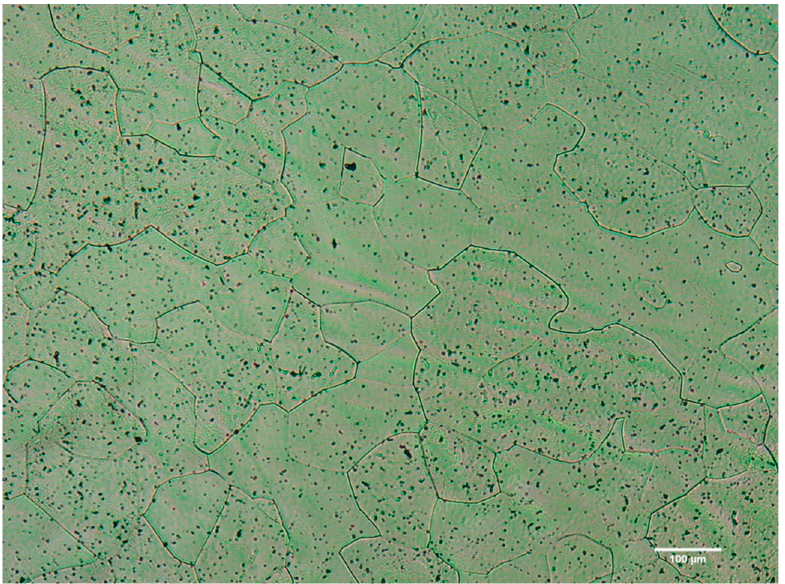
Figure 2. Optical micrograph of the Ti-25Ta-25Nb-5Sn alloy. Image of the microstructure of the Ti-25Ta-25Nb-5Sn after quenching.